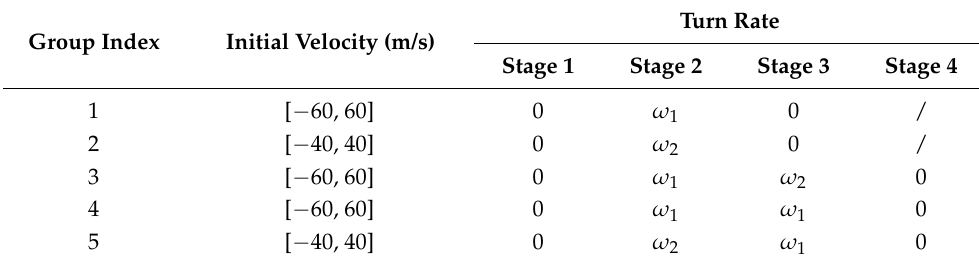
Table 1. The kinematic parameters of the target